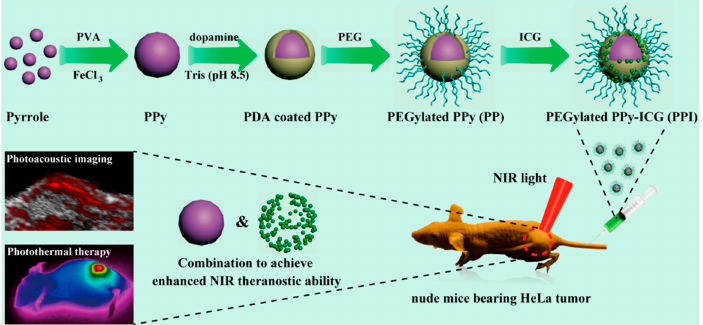
Figure 10. Schematic illustration of the formation and NIR theragnostic applications of PEGylated indocyanine green (ICG)-loaded polypyrrole nanoparticles (PPI NPs). Reprinted with permission from [81]. Copyright, American Chemical Society (2019).